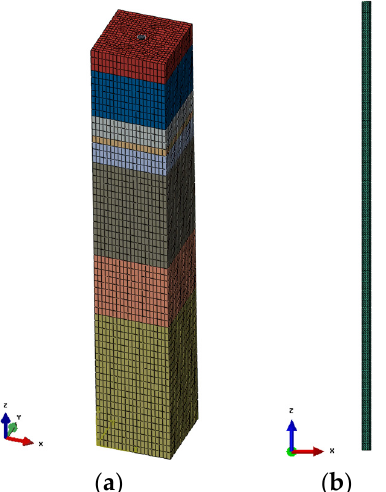
Figure 1. Finite element models of the soil and pile. ( a ) Soil, ( b ) pile.